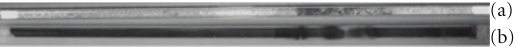
Figure 2: The picture of NiO/Al 2 O 3 (a) and Ni/Al 2 O 3 (b) after experiment. temperature control. But why did there appear totally oppo- site results for pure metal catalysts and supported catalysts with the same reaction system and operation